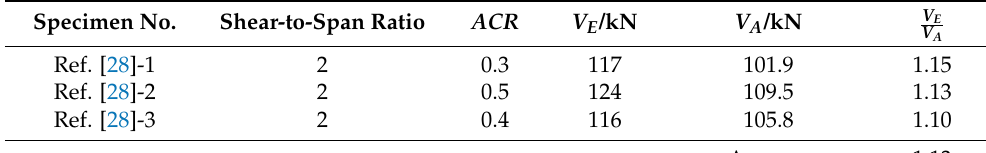
Table 6. The Calculated Results Based on Ref. [28]. Specimen